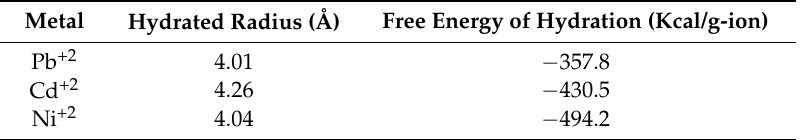
Table 4. Relevant ionic properties functional to retention